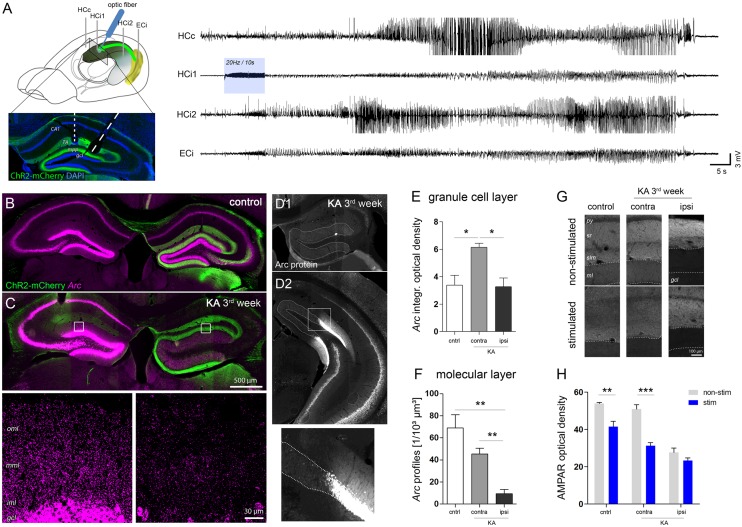
Region-specific responses of DGCs to optogenetically-induced seizures. (A) Schematic showing the position of electrodes (HCc, contralateral hippocampus; HCi1, ipsilateral septal; HCi2, ipsilateral temporal; ECi, ipsilateral entorhinal cortex). Brain sketch modified from Witter and Amaral (2004). Optic fibers were implanted in the ipsilateral septal region to obtain a spatially confined stimulation of ChR2-expressing entorhinal afferents (ChR2-mCherry, green). Representative LFP recording on the right shows an optogenetically-evoked generalized seizure. Blue shading denotes the local delivery of pulsed blue light, here, at 20 Hz for 10 s. (B,C) Representative images showing seizure-induced upregulation of Arc mRNA (magenta) in the hippocampus of healthy controls and chronically epileptic mice, respectively. High-magnification confocal images for C are shown below. Note the lack of Arc mRNA upregulation in DGCs of the ipsilateral, sclerotic hippocampus. (D1–D2) Representative image of immunohistochemical staining for Arc protein. (E) Corresponding quantification of t Arc mRNA density in the granule cell layer and (F) the molecular layer. Number of mice: ncntrl = 4, nKA-contra = 3, nKA-ipsi = 4. One-way ANOVA, Newman–Keul’s post-test. ∗P < 0.05, ∗∗P < 0.01. (G) Comparison of AMPAR density in stimulated mice which experienced a series of evoked behavioral seizures and in non-stimulated mice. (H) Corresponding quantitative analysis of AMPAR density in the molecular layer of the hippocampus of stimulated (blue bars) and non-stimulated (gray bars) controls (nnon-stim = 4; nstim = 4) and chronically epileptic mice (nnon-stim = 4; nstim = 4). Two-way ANOVA, Bonferroni’s post-test. ∗∗P < 0.01, ∗∗∗P < 0.001.